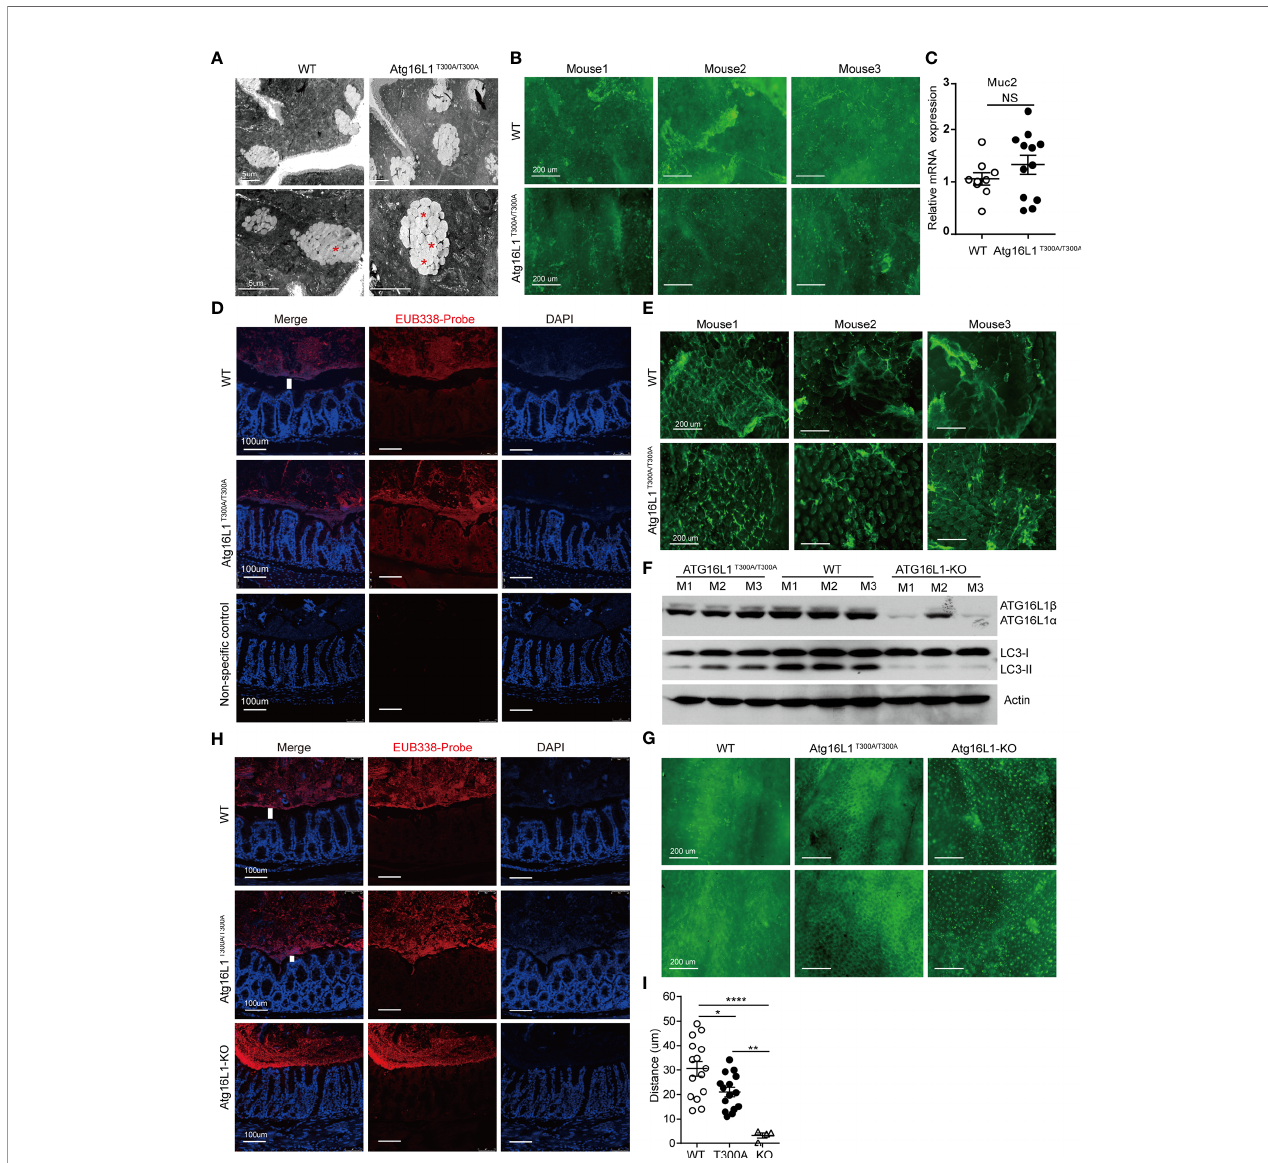
FIGURE 4 | Impaired function of mucin secretion in Atg16L1 T300A/T300A goblet cells is autophagy-dependent. Isolated colon or distal ileum tissues from cohoused WT and Atg16L1 T300A/T300A mice stained with Helix pomatia lectin for mucus secretion by whole-mount staining, and microbiota localization in the colon was detected by FISH staining. n= 6 – 8 mice/group. (A) Representative transmission electron microscopy images were taken from intestine sections of cohoused WT and Atg16L1 T300A/T300A mice. Red asterisks indicate enlarged granules; n = 5 mice per genotypes. Scale bars, 5 m m. (B) Representative whole-mount images of tissues taken from the colon mucosal surface of cohoused WT and Atg16L1 T300A/T300A mice stained with Helix pomatia lectin (Lectin-HPA) that labels mucus (green). Images are representative of at least three independent experiments. Scale bars, 200 m m. (C) Quantitative real-time PCR analysis of mucus (Muc2) mRNA of cohoused WT and Atg16L1 T300A/T300A mouse colonic epithelium; results are presented relative to those of wild-type mice. (D) Visualization of microbiota localization relative to the intestinal mucosa of the colon surface by FISH. Sections were hybridized with the EUB338 probe recognizing the 16S rRNA genes of all bacteria (red) or non- EUB338 as a non-speci fi c control and counterstained with DAPI (blue). Scale bar: 100 m m. (E) Representative whole-mount images taken from the ileum mucosal surface in cohoused WT and Atg16L1 T300A/T300A mice stained with Helix pomatia lectin (Lectin-HPA) that labels mucus (green). (F) Colonic epithelial cells were isolated from the colon of cohoused WT, Atg16L1 T300A/T300A , and Atg16L1-KO mice, and Western blot analysis was used to detect Atg16L1 and LC3 changes from whole-cell lysates. Actin was used as loading control. n = 3 mice/group. (G) Representative whole-mount images of tissues taken from the colon mucosal surface of cohoused wild-type, Atg16L1 T300A/T300A , and Atg16L-KO mice stained with Helix pomatia lectin (Lectin-HPA) that labels mucus (green). (H) Visualization of microbiota localization relative to the intestinal mucosal of the colon surface by FISH. Sections were hybridized with the EUB338 probe recognizing the 16S rRNA genes of all bacteria (red) and counterstained with DAPI (blue). Scale bar: 100 m m. The white column indicates the distance between the apical surface of the epithelium and the luminal contents. (I) Quanti fi cation of the distance of separating villi from microbiota in (D, H) . Data are from at least three independent experiments. Each symbol represents an individual animal. *p < 0.05, **p < 0.01, ****p < 0.0001. NS, not signi fi cant (non-parametric test followed by a Mann – Whitney test; one/two-way ANOVA analysis followed by a Tukey/Bonferroni post hoc test for three-group